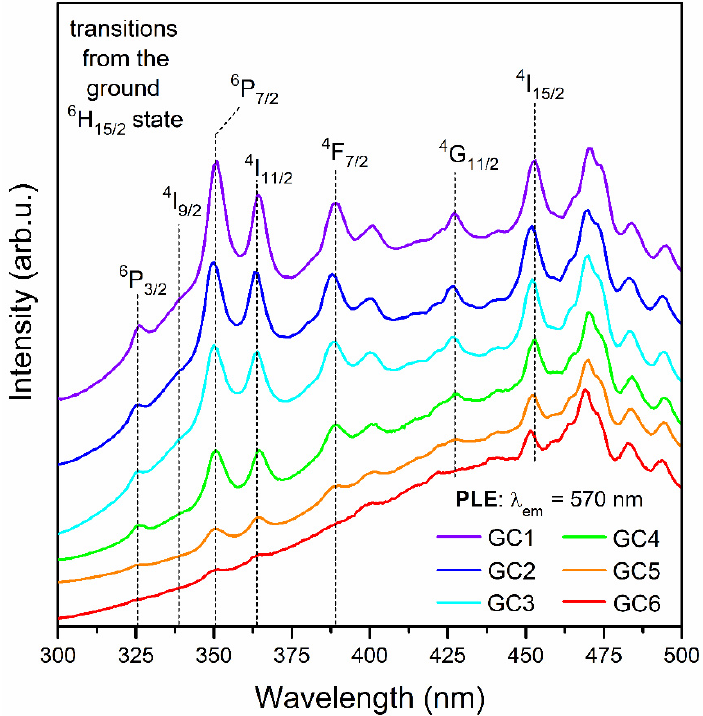
Figure 7. Photoluminescence excitation spectra (PLE) recorded for the series of fabricated SiO 2 - LaF 3 :Dy 3+ nano-glass-ceramics by monitoring the yellow emission at λ em = 570